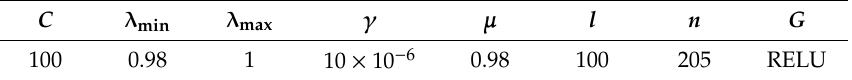
Table 1. Training parameters of the proposed algorithm.